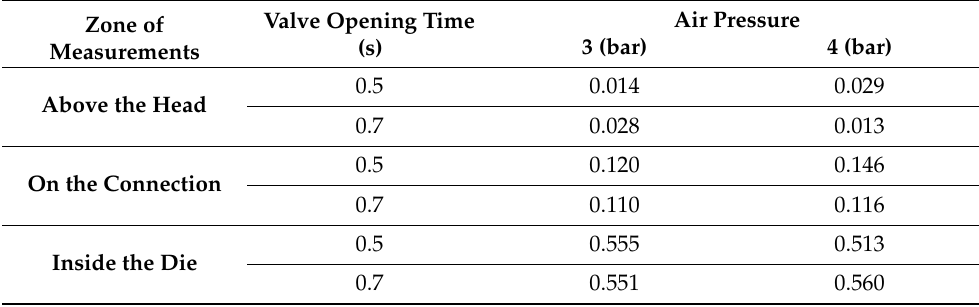
Table 3. Average of five tests of the lubricant amount (in grams) deposited in selected areas for the variants of pressure and the time of its exertion under consideration.